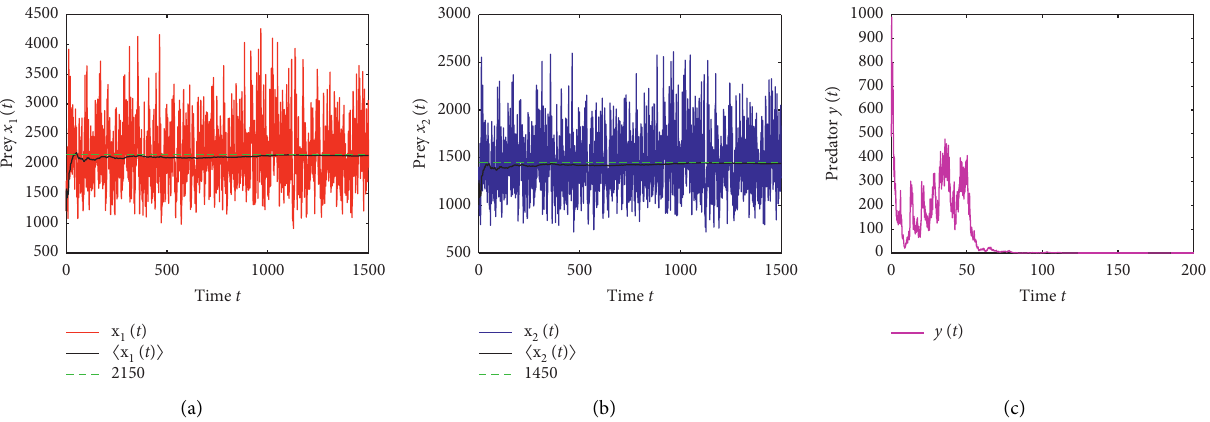
Figure 17: The trajectories of stochastic model (5) with σ 2 and (c) predator y ( t )